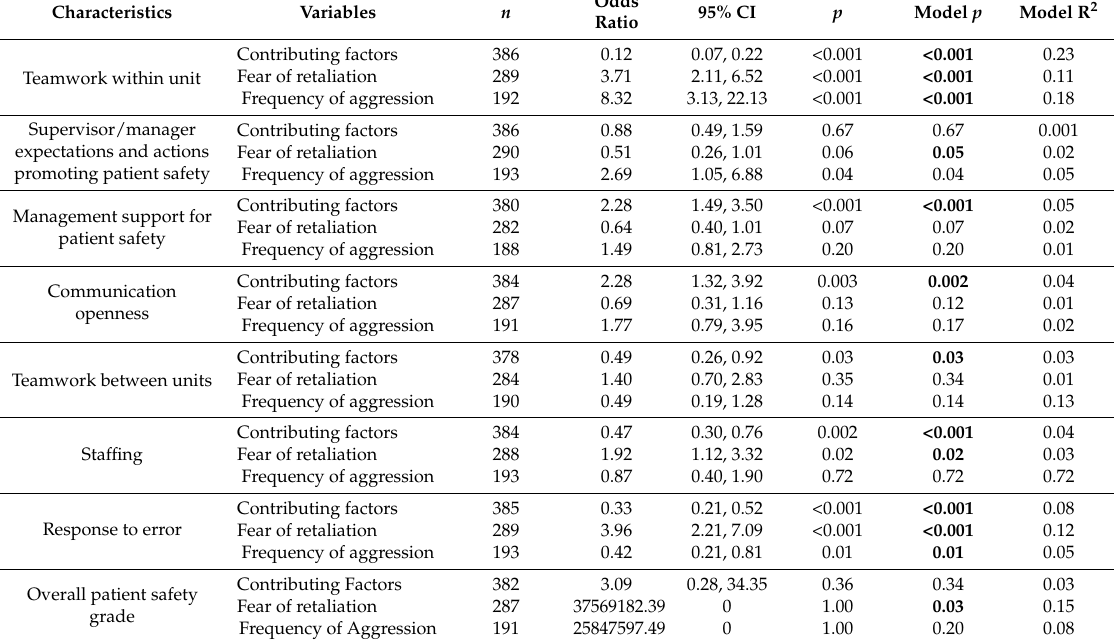
Table 3. Regression coefficients.